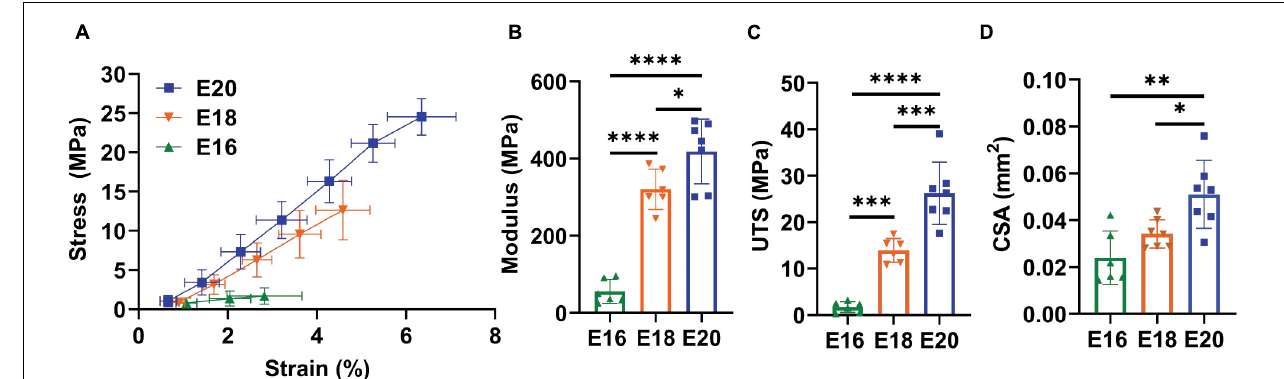
FIGURE 2 | Flexor digitorum brevis (FDB) digit II tendon macroscale mechanical response with maturation. (A) Equilibrium stress vs. strain response for E16 (HH42, n = 6), E18 (HH43, n = 7), and E20 (HH46, n = 7) timepoints. (B) Significant increase in equilibrium modulus response with embryonic maturation. (C) Significant increase in ultimate tensile stress (UTS) with development. (D) A significant increase in the cross sectional (CSA) of the tendon was observed with maturation when measured under confocal microscopy. Significance was tested with a one-way ANOVA with post hoc Tukey’s test corrected for multiple comparisons. Data represented as mean ± standard deviation. ∗ p < 0.05, ∗∗ p < 0.01, ∗∗∗ p < 0.001, and ∗∗∗∗ p < 0.0001.